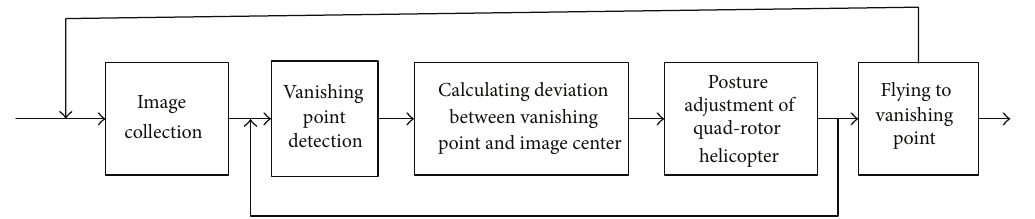
Figure 9: The workflow of quad-rotor helicopter navigation